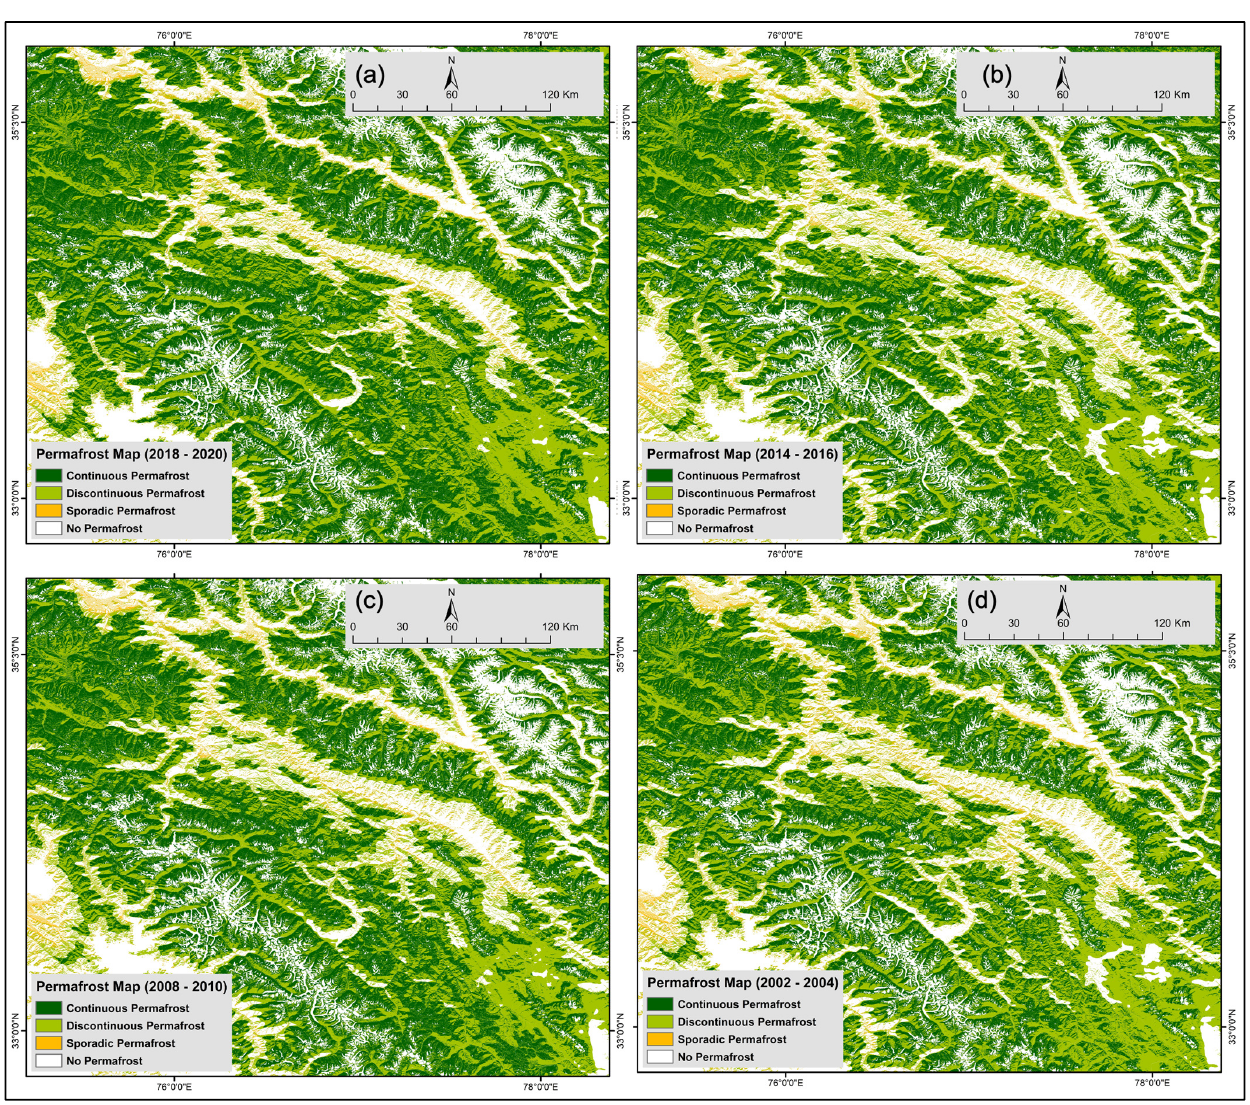
Figure 8. Maps of the selected parts of Ladakh and Himachal Pradesh showing the permafrost extent for ( a ) 2002-04, ( b ) 2008-10, ( c ) 2014-16, and ( d ) 2018-20.